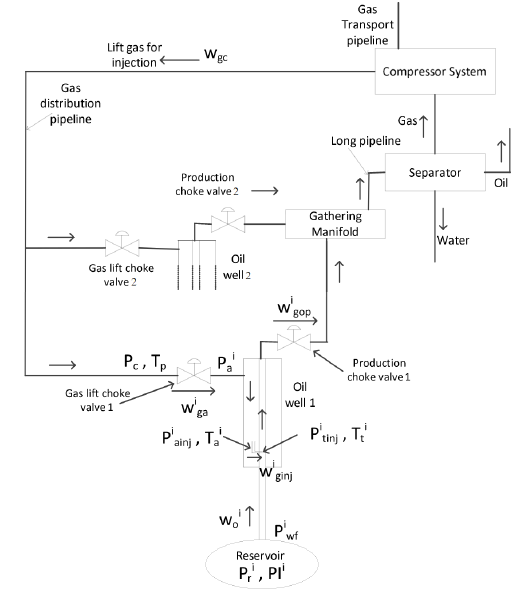
Figure 1: Schematic of the oil field adapted from Sharma et al.